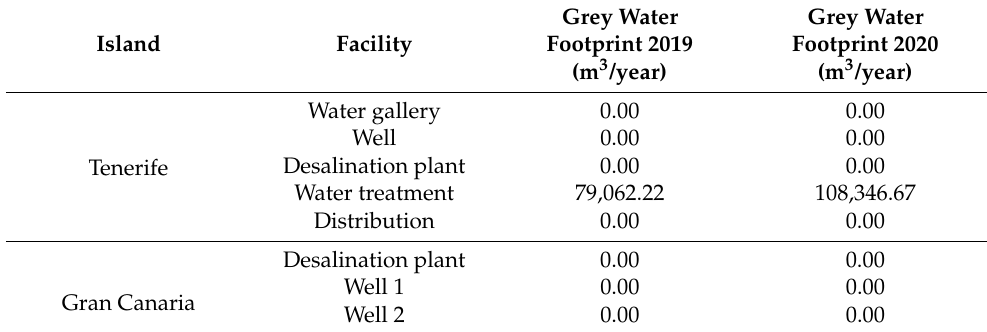
Table 2. Results of the grey water footprint at the eight facilities studied in the Canary